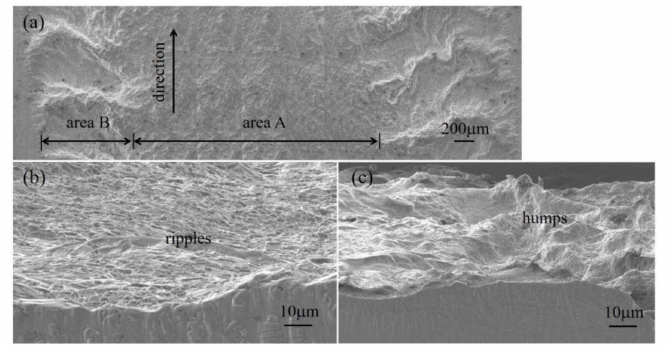
Figure 2. Surface morphology of one track nitrided in a gas atmosphere of 80% nitrogen and 20% argon. ( a ) Scanning electron microscope (SEM) image of the surface, and at higher magnification ( b ) Area A and ( c ) Area